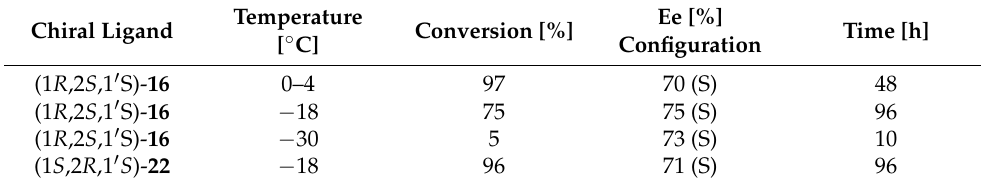
Table 4. Optimization of reaction temperature.